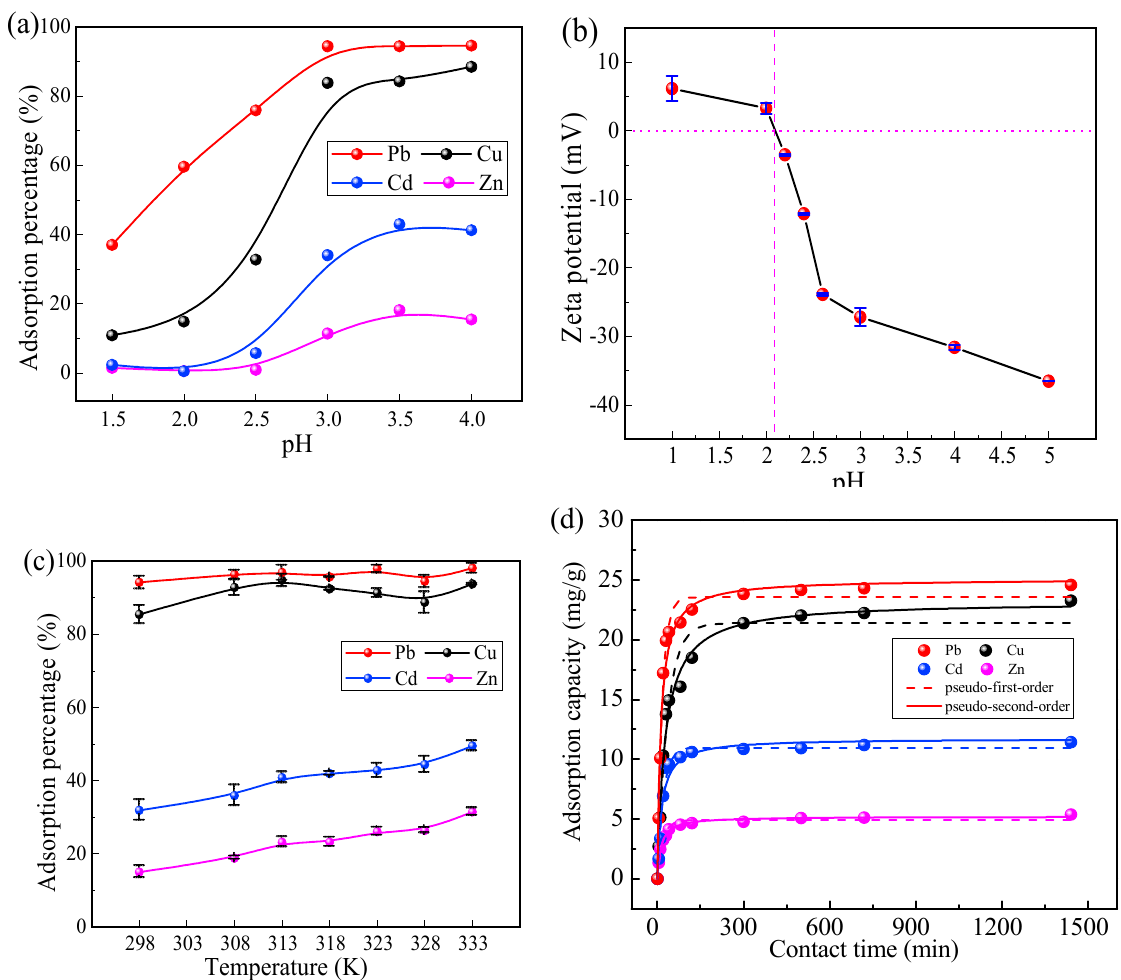
Figure 4. ( a ) Effect of pH on the adsorption percentage of Pb(II), Cu(II), Cd(II) and Zn(II) ions onto the WAC-resin; ( b ) zeta potential of the WAC-resin as the function of pH; ( c ) effect of temperature; and ( d ) effect of contact time (liquid–solid ratio: 250 mL/g, and initial concentration: 100 mg/L).